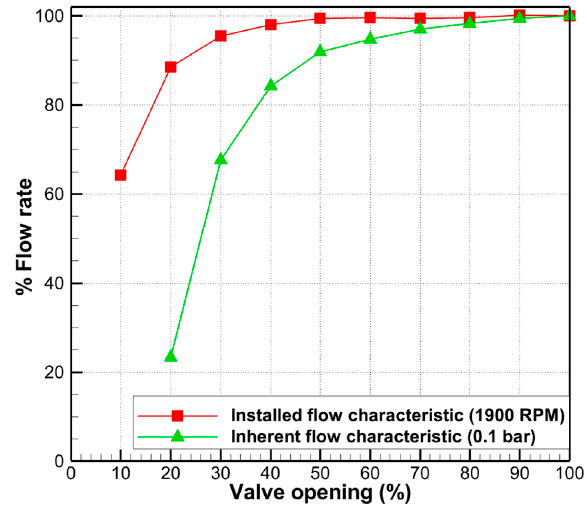
Figure 10. Comparison of the inherent and installed characteristics.